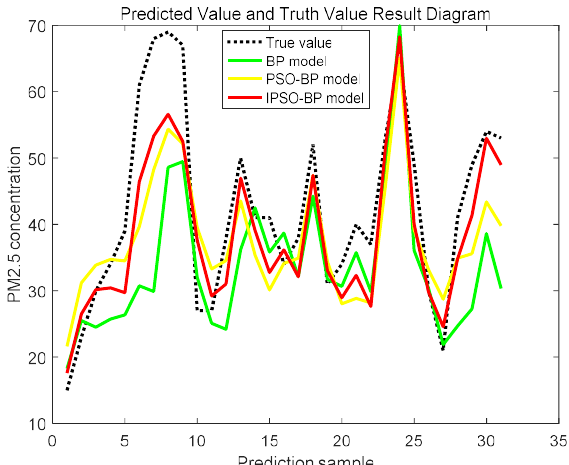
Figure 2. Predicted value and truth value result